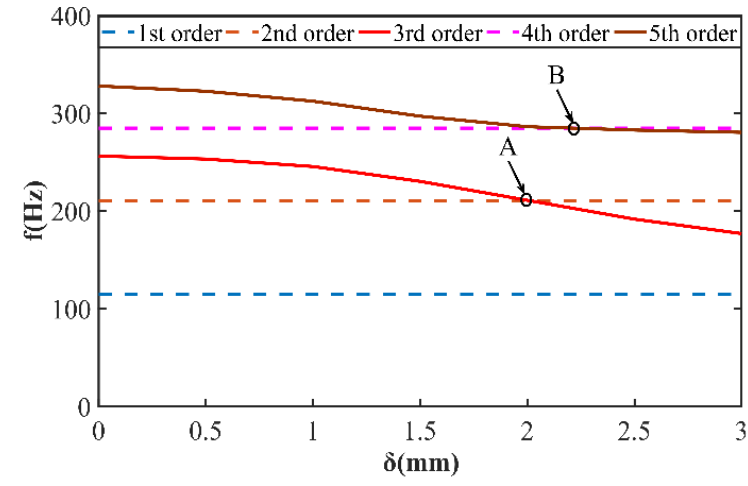
Figure 13. Variation trend of natural frequency of parallel non-concentricity in the range of 0 mm~3 mm. More in detail, when δ increases from 0 to 3 mm, the 1st, 2nd, and 4th order natural frequencies change little, while the 3rd and 5th order natural frequencies change obviously. With the increase in δ , the 3rd and 5th order natural frequencies decrease. When δ increases to 2.1 mm, the 3rd order natural frequency will be less than the 2nd order natural frequency. Thusm the corresponding 2nd and 3rd order modals interchange. When δ continues to increase to 2.25 mm, the 5th natural frequency will be less than the 4th natural frequency, and the corresponding 4th and 5th modals will be interchanged.